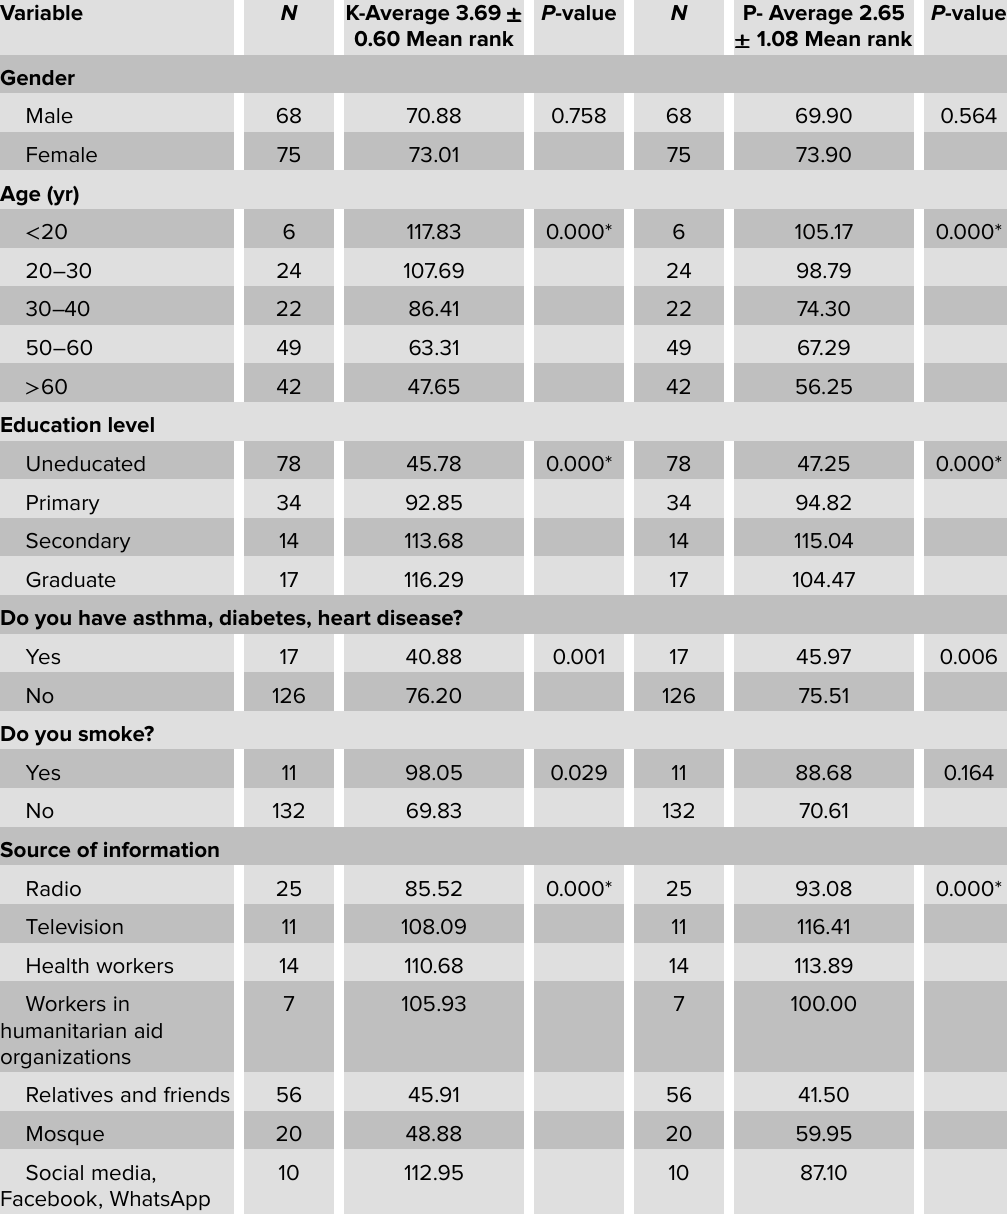
TABLE 6: Comparison of mean scores of knowledge and practice with demographic characteristics ( n =